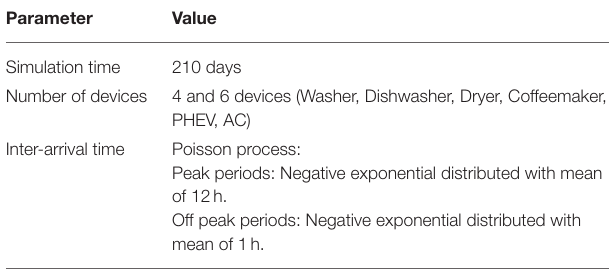
TABLE 3 | Simulation parameters.